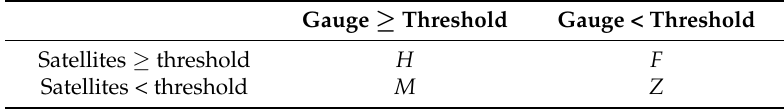
Table 2. Contingency table comparing rainfall retrievals by satellites and